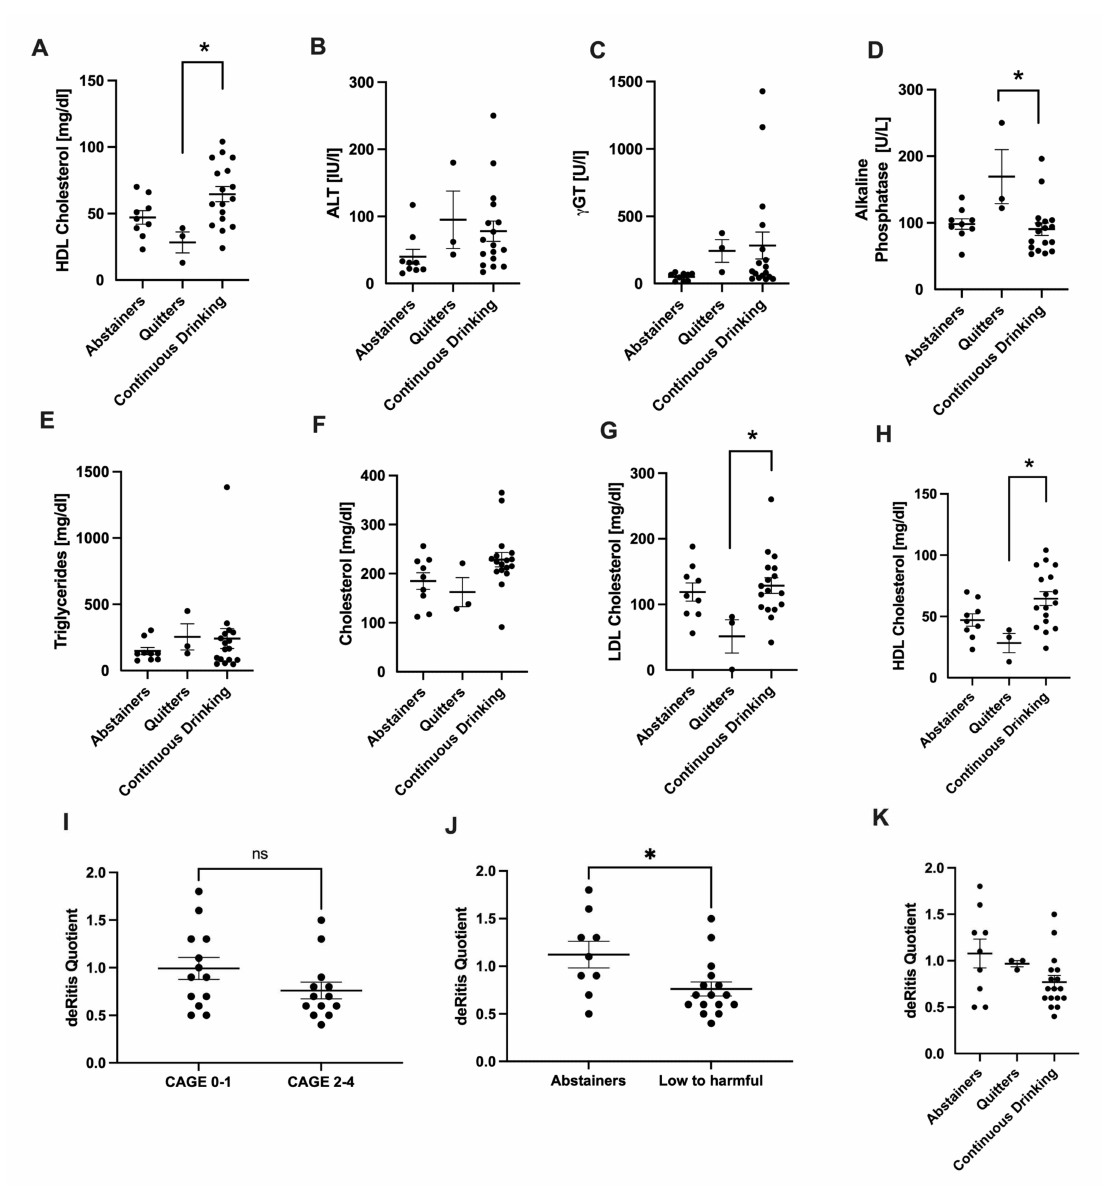
Figure 4. Analysis of drinking history. Serum parameters of liver injury ( A – D ) and lipid metabolism ( E – H ) were analyzed in abstainers, quitters, and continuously drinking patients. DeRitis quotient was compared in CAGE 0–1 versus CAGE 2–4 (( I ), CAGE questionnaire), abstainers versus low to harmful consumers (( J ), AUDIT questionnaire) as well as with regard to the drinking history ( K ). * p < 0.05. ns stands for not